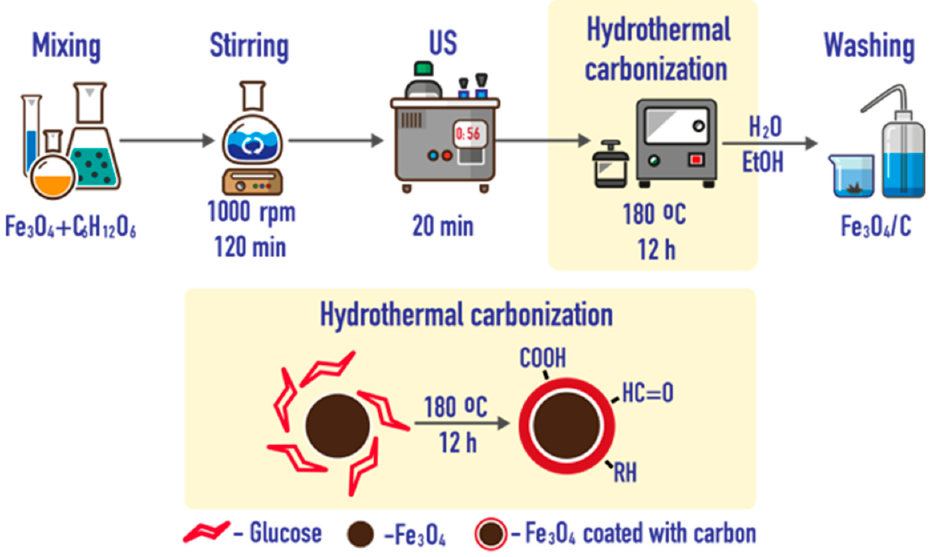
Figure 12. Synthesis of IONs coated with porous carbon.